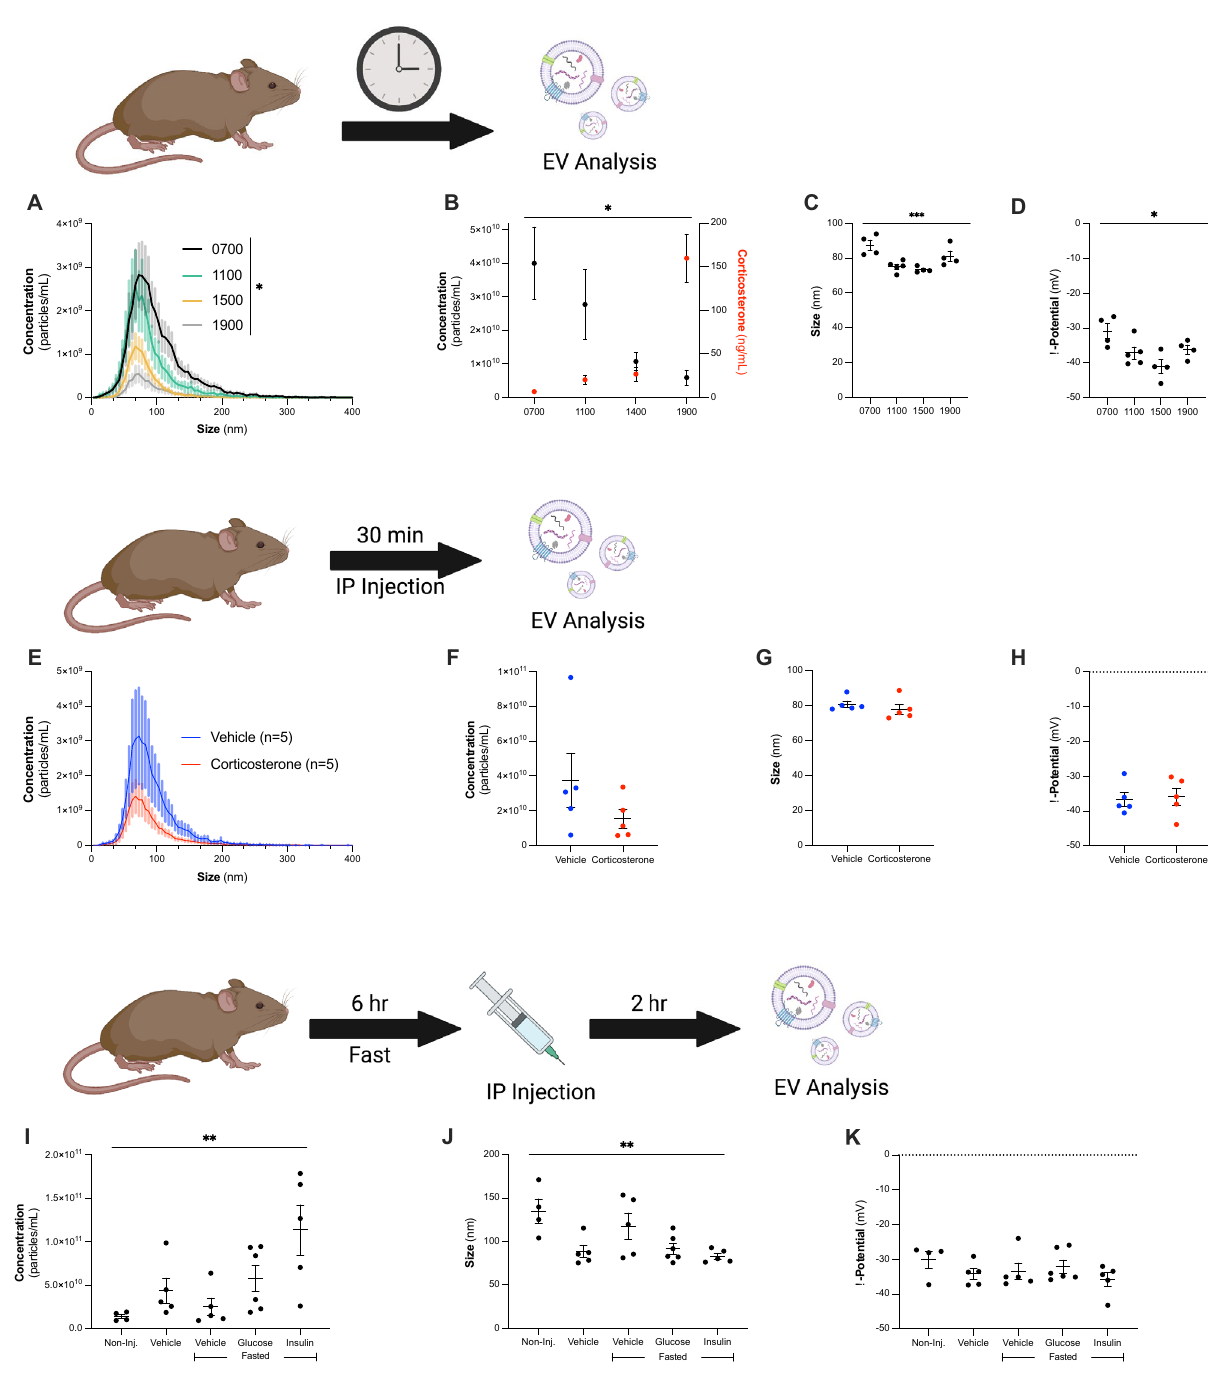
Figure 1. Circulating extracellular vesicle (EV) concentrations significantly change in response to altered metabolic state. ( A ) EV concentration in circulation significantly changes over the course of the day (one-way ANOVA, main effect of time, F 3,13 = 3.509, p = 0.0463). 0700 shown in black, n = 4; 1100 in green, n = 5; 1500 in yellow, n = 4; 1900 in gray, n = 4. ( B ) The concentration of circulating EVs decreases over the course of the day (left y-axis, black, one-way ANOVA, main effect of time, F 3,13 = 3.509, p = 0.0463), while corticosterone levels increase over the course of the day (right y-axis, red, one-way ANOVA, main effect of time, F 3,13 = 25.62, p < 0.0001). ( C ) The size of circulating EVs significantly changes over the course of the circadian rhythm (one-way ANOVA, main effect of time, F 3,13 = 8.454, p = 0.0023), and ( D ) the ζ-potential is significantly changed (one-way ANOVA, main effect of time, F 3,13 = 5.023, p = 0.0158). ( E , F ) IP injections of corticosterone (red, n = 5) trend to decrease EV concentration in non-pregnant dams as compared to vehicle injections (blue, n = 5, two-tailed t -test, t 8 = 1.351, p = 0.2137). Corticosterone injections did not impact ( G ) size (two-tailed t -test, t 8 = 1.351, p = 0.2137) or ( H ) ζ-potential of circulating EVs (two-tailed t -test, t 8 = 0.2309, p = 0.8232). ( I ) Non- pregnant dams received either no injection (n = 4), vehicle injection (saline, n = 5), 6 h fasting with a vehicle injection (n = 5), 6 h fasting with a glucose injection (3 mg glucose/g body weight, n = 6), or 6 h fasting with an insulin injection (0.8 mU insulin/g body weight, n = 5). There was a significant effect of injection on concentration (one-way ANOVA, main effect of treatment, F 4,20 = 4.883, p = 0.0065) and ( J ) size (one-way ANOVA, main effect of treatment, F 4,20 = 4.764, p = 0.0073) of circulating EVs but not on ( K ) ζ-potential of circulating